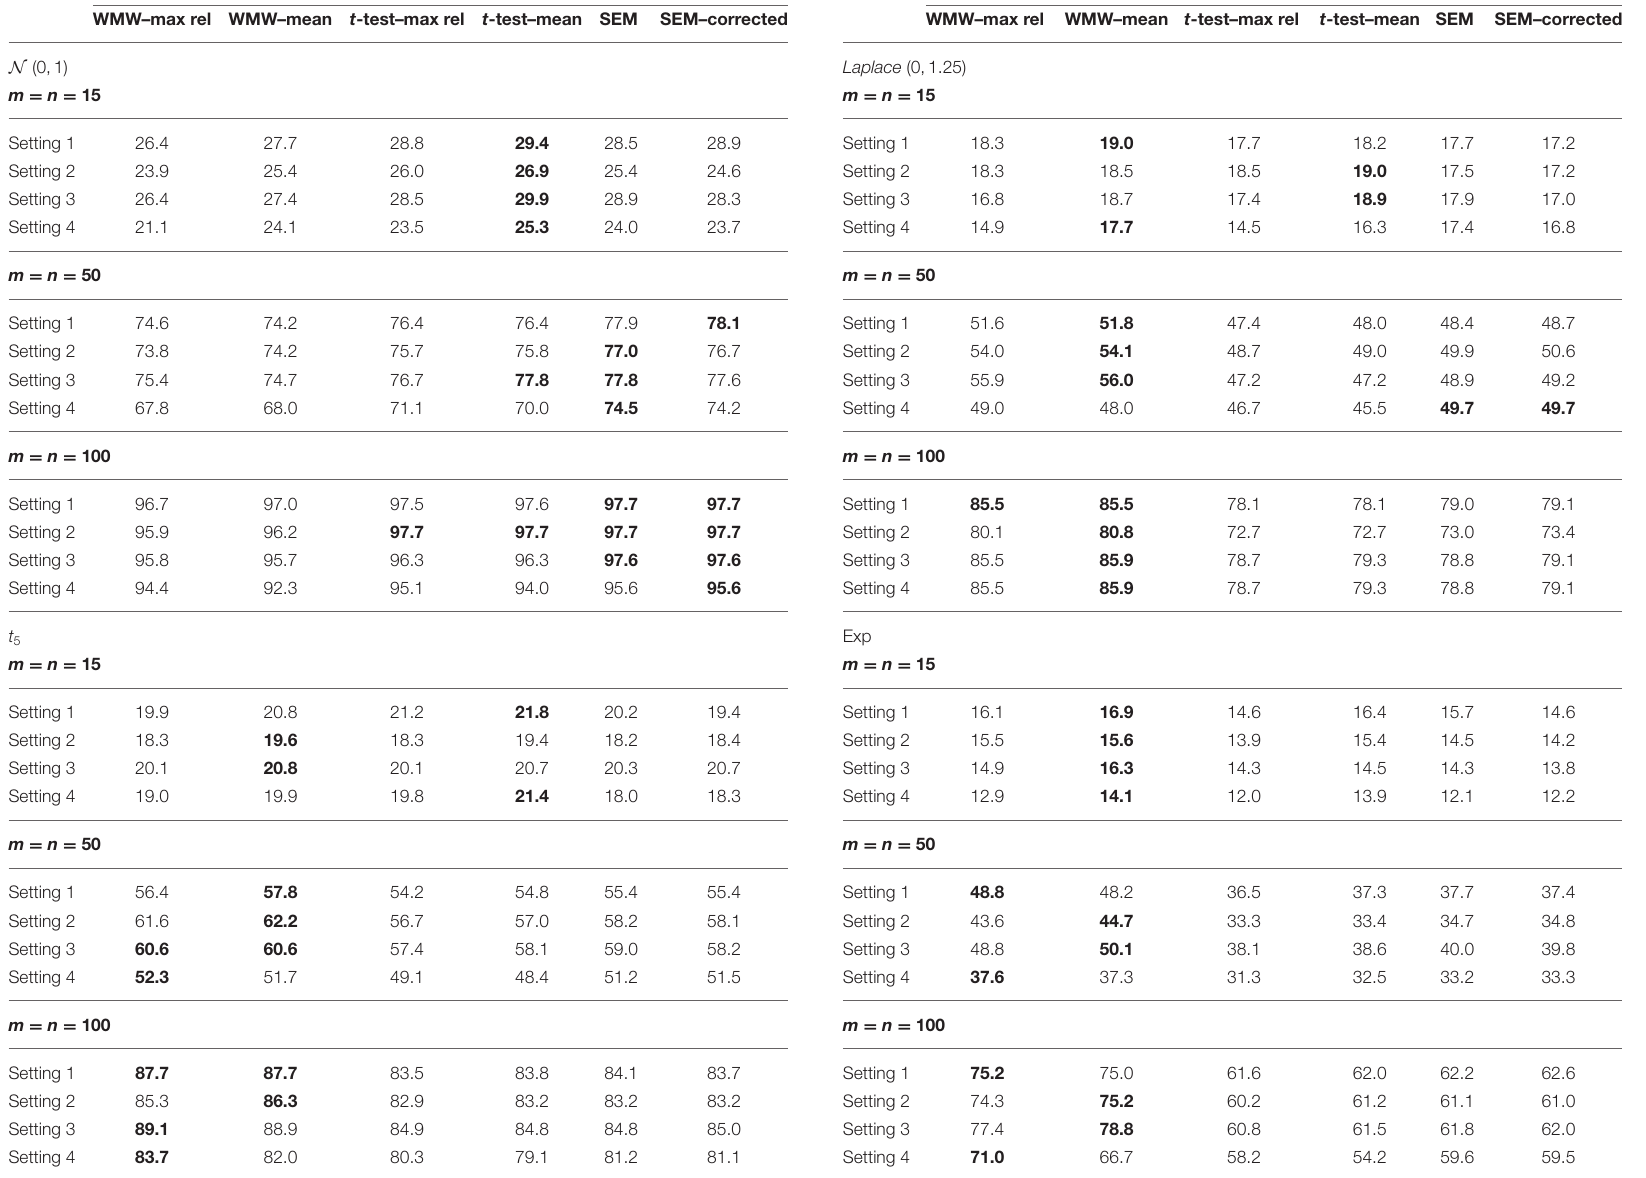
TABLE 2 | Empirical power from the simulation study with the indicators having an overall reliability of 60% and a linear relationship with the latent variable. Linear